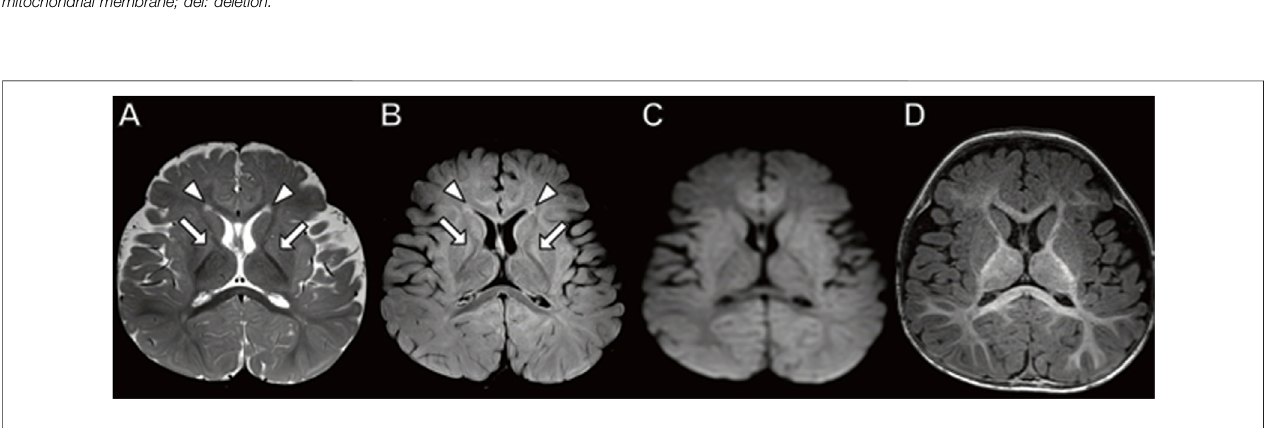
FIGURE 1 | Brain MRI in 7-month-old boy with MICU1 mutation. (A) Axial T2 and (B) axial fl uid-attenuated inversion recovery (FLAIR) images demonstrate a mild signal hyperintensity in the globus pallidus (arrows) and frontal horn periventricular white matter (arrowheads). No abnormal signal on diffusion-weighted (C) or T1- weighted (D)